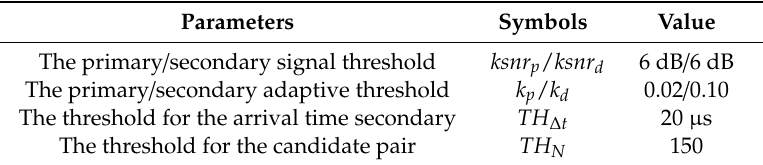
Table 2. Parameters for the laboratory measurement with the phantom.